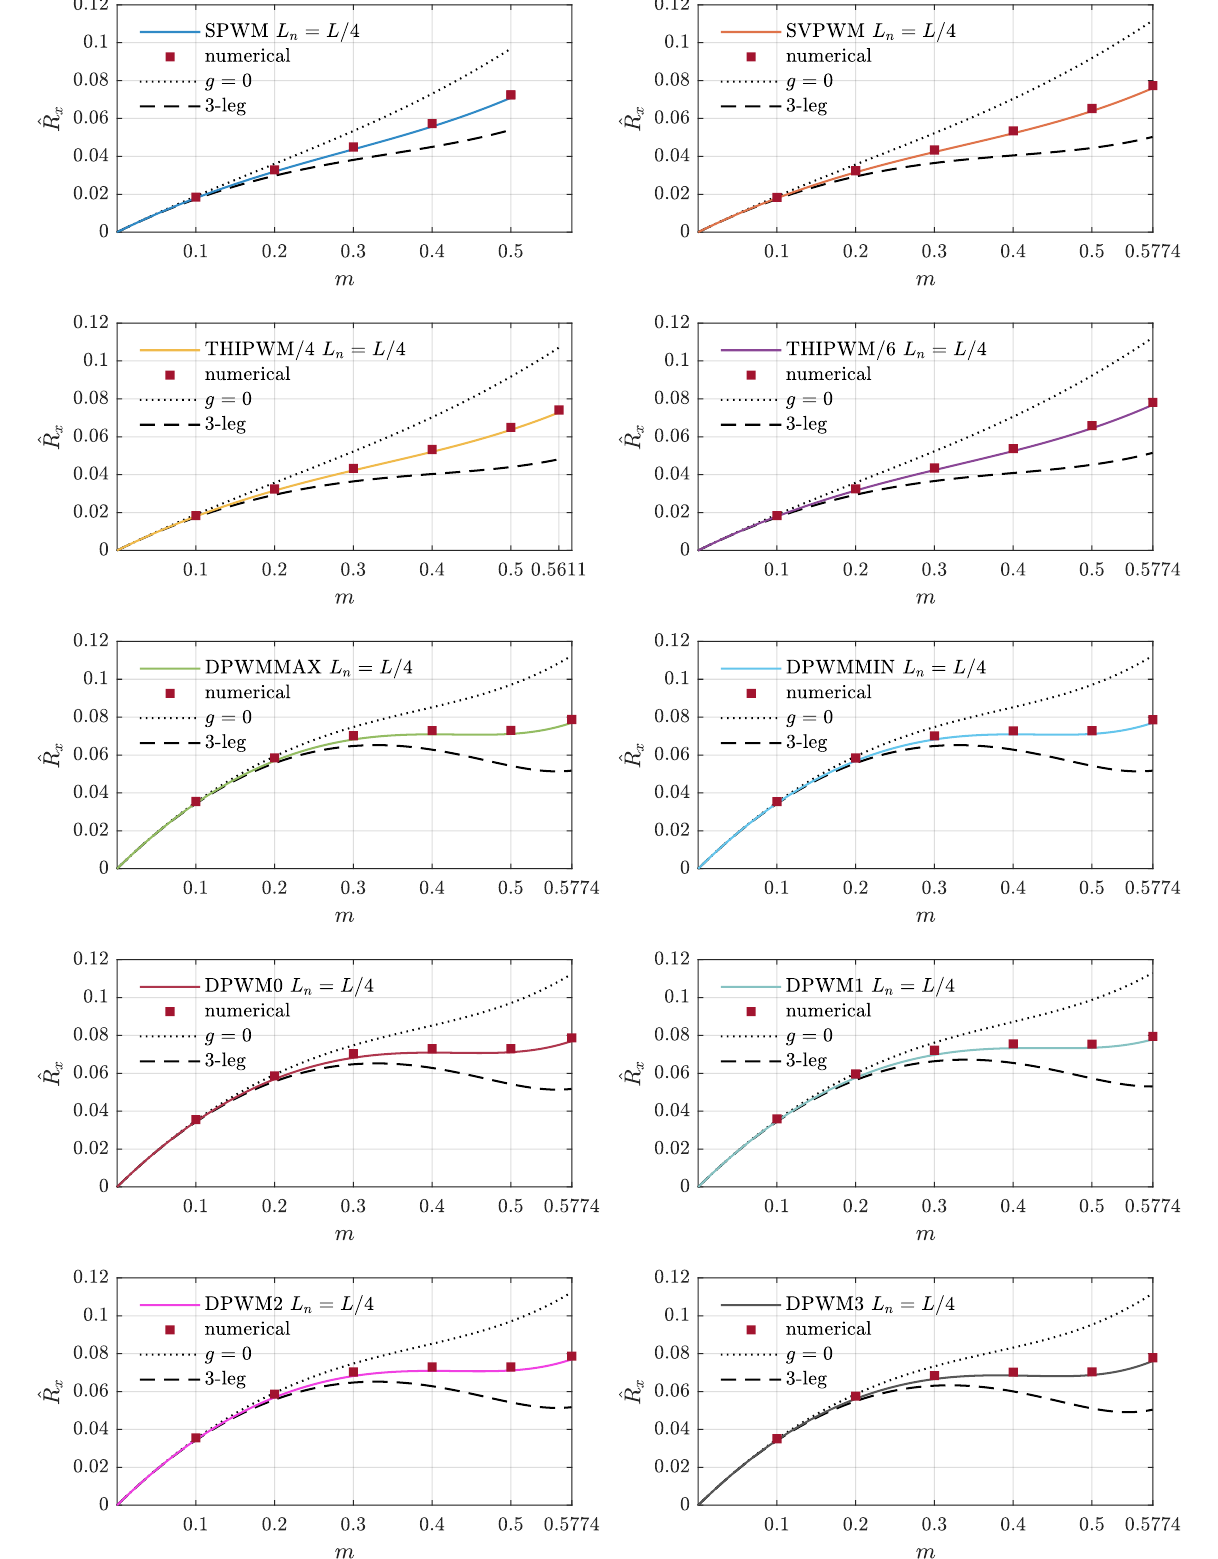
Figure 2. Numerical validation of normalized phase-current-ripple RMS in the case of multiple PWM common-mode injections for L n = L /4 (i.e., g = 0.25). Normalization base V dc / ( 2 Lf sw )